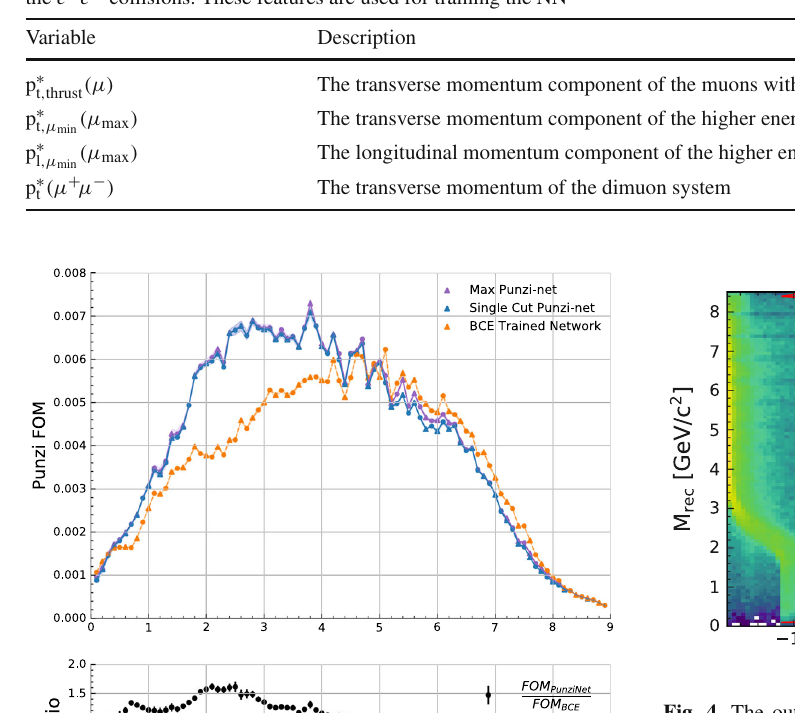
Fig. 4 The output distribution of all signal events using the Punzi- loss trained NN, overlaid with the the optimal decision threshold for each signal hypothesis. The classification variable shows the NN output before applying the last sigmoid function in order to better see the separation. The optimal cut value can be replaced by a uniform cut without any significant difference in the resulting selection